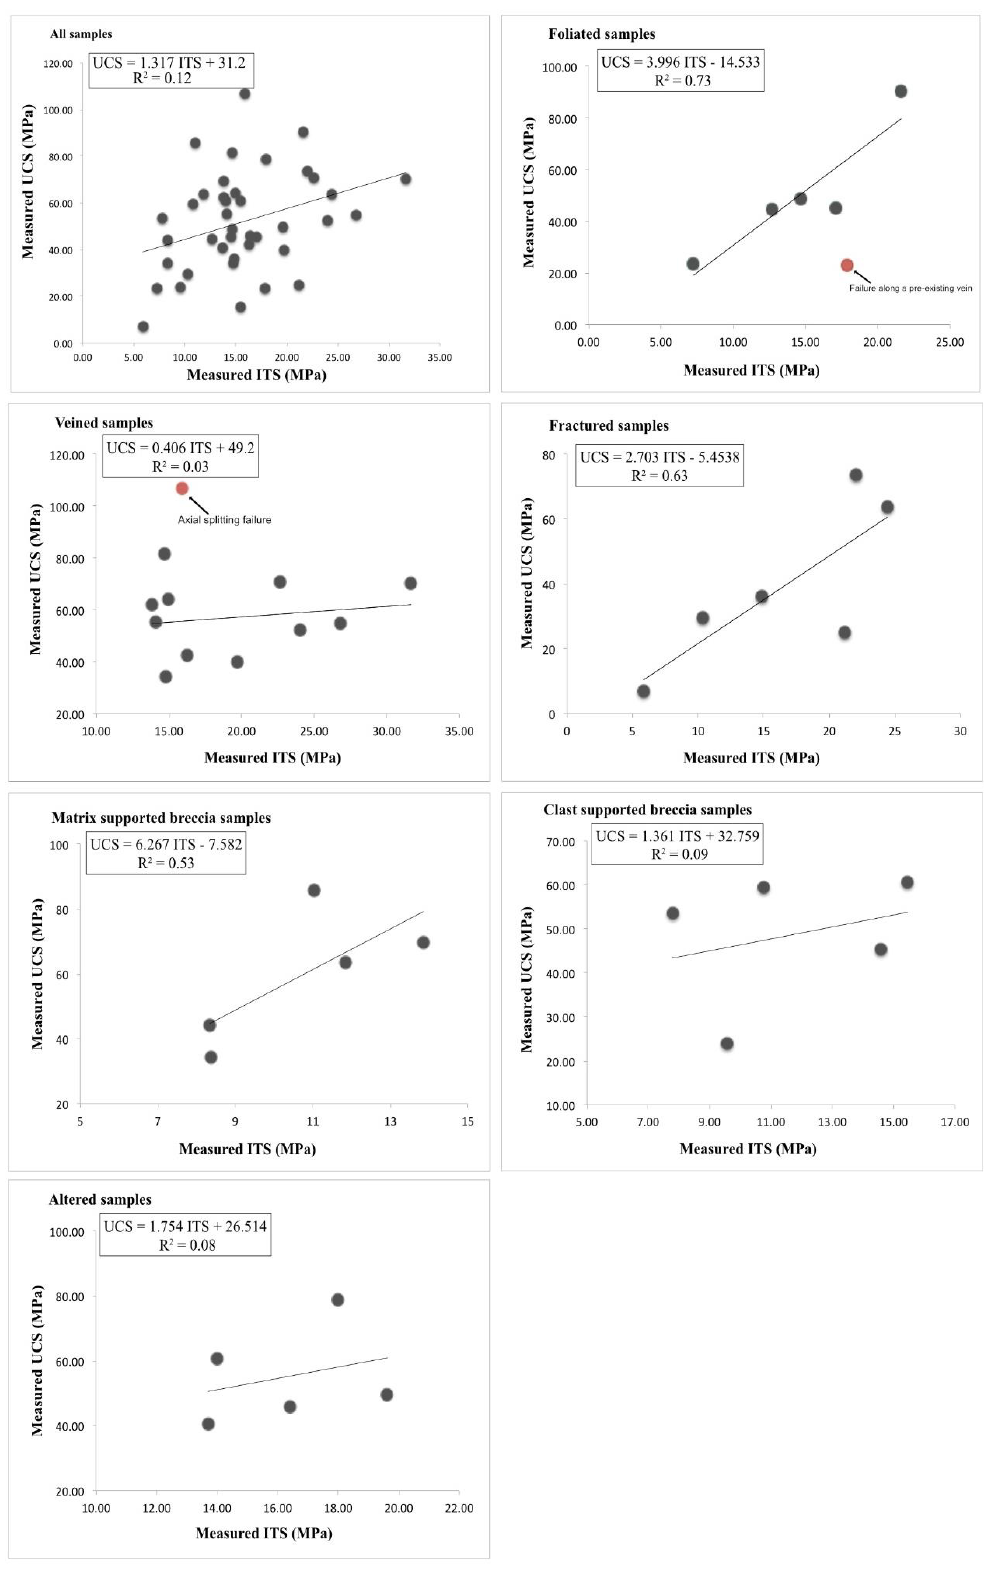
Figure 10. Measured ITS (MPa) vs. measured UCS (MPa) for the investigated rocks. Each plot represents a pre-existing texture. The red point represents a sample that has a different failure mode to the other samples, causing that sample to deviate from the trend line.